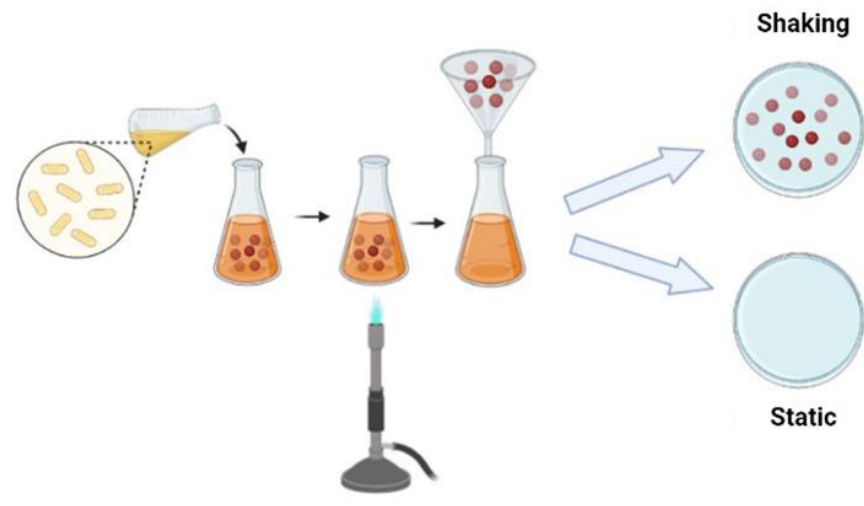
Figure 2. Schematic representation of the BC production strategy.